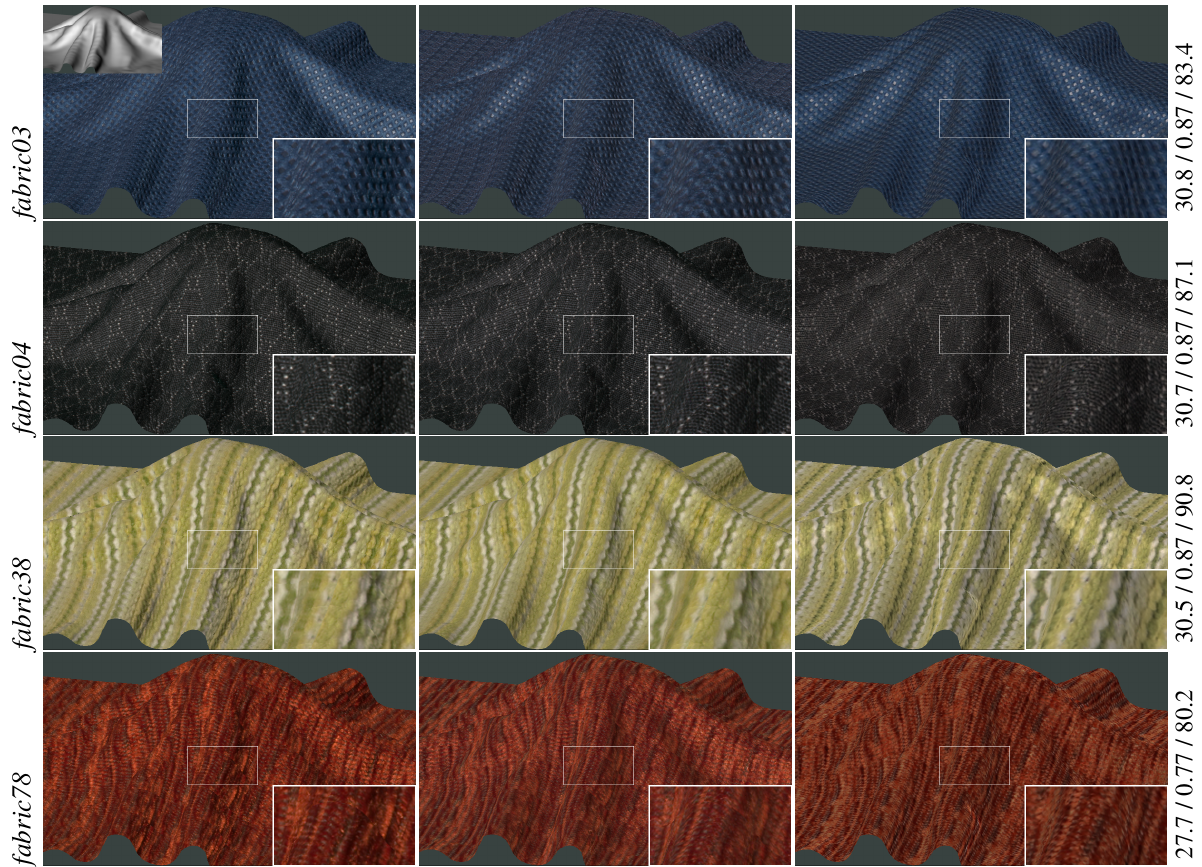
Figure 6. A comparison of renderings: (left) using the entire reference BTF datasets (6561 images), (middle) using BTF reconstruction from a sparse subset of reference BTF (208 images), (right) using BTF reconstruction of the proposed measurements (208 images). At the end of each row are PSNR[dB]/SSIM/VDP2 values between the first two